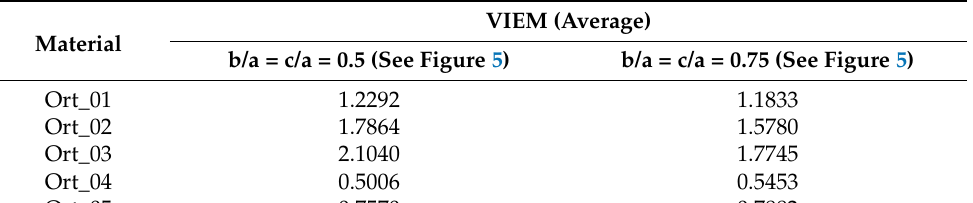
Table 17. Normalized tensile stress component ( σ xx / σ oxx ) within the orthotropic oblate spheroidal inclusion due to uniform remote tensile loading ( σ oxx ).